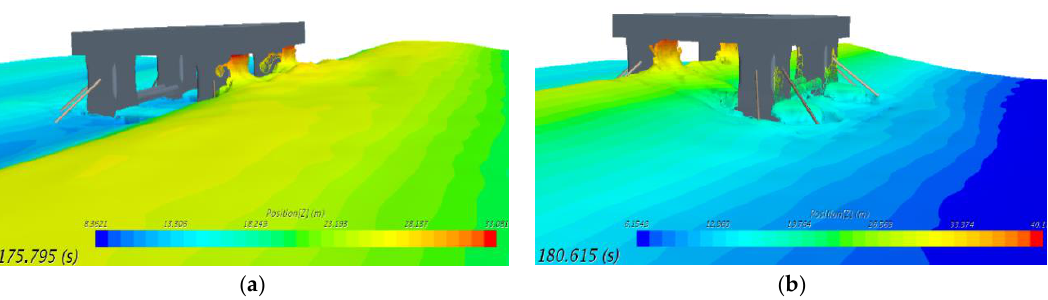
Figure 17. Evolution of free surface at two moments under freak wave. ( a ) t = 175.795 s. ( b ) t = 180.615 s.